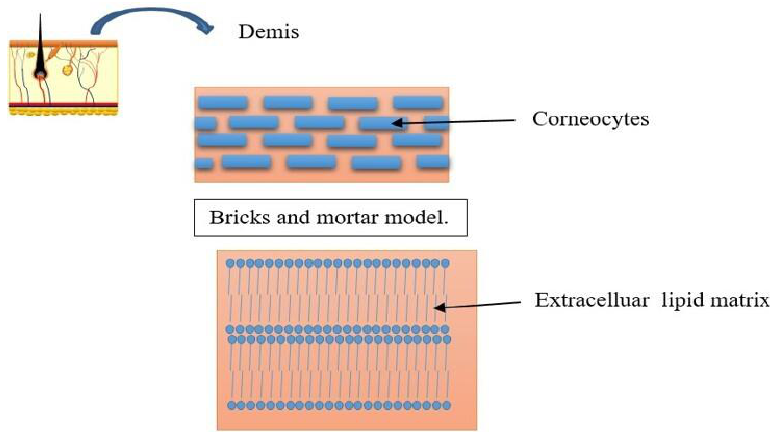
Figure 3. The structure of Stratum Corneum. Extracellular lipids produce a bilayer lamellar phase. Lateral packing is essential for skin health. Orthorhombic packing density is high. Hexagonal packing density is